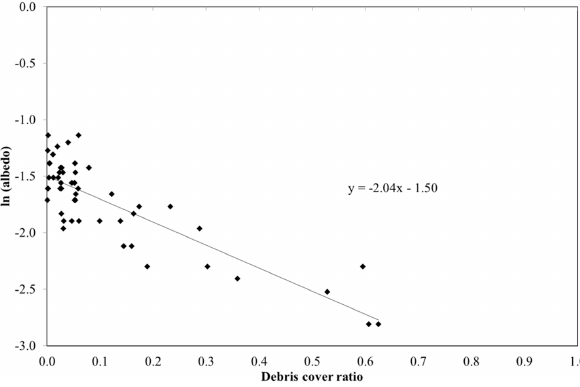
Figure 5. Debris cover ratio vs. albedo natural logarithm values (2011–2013 data).